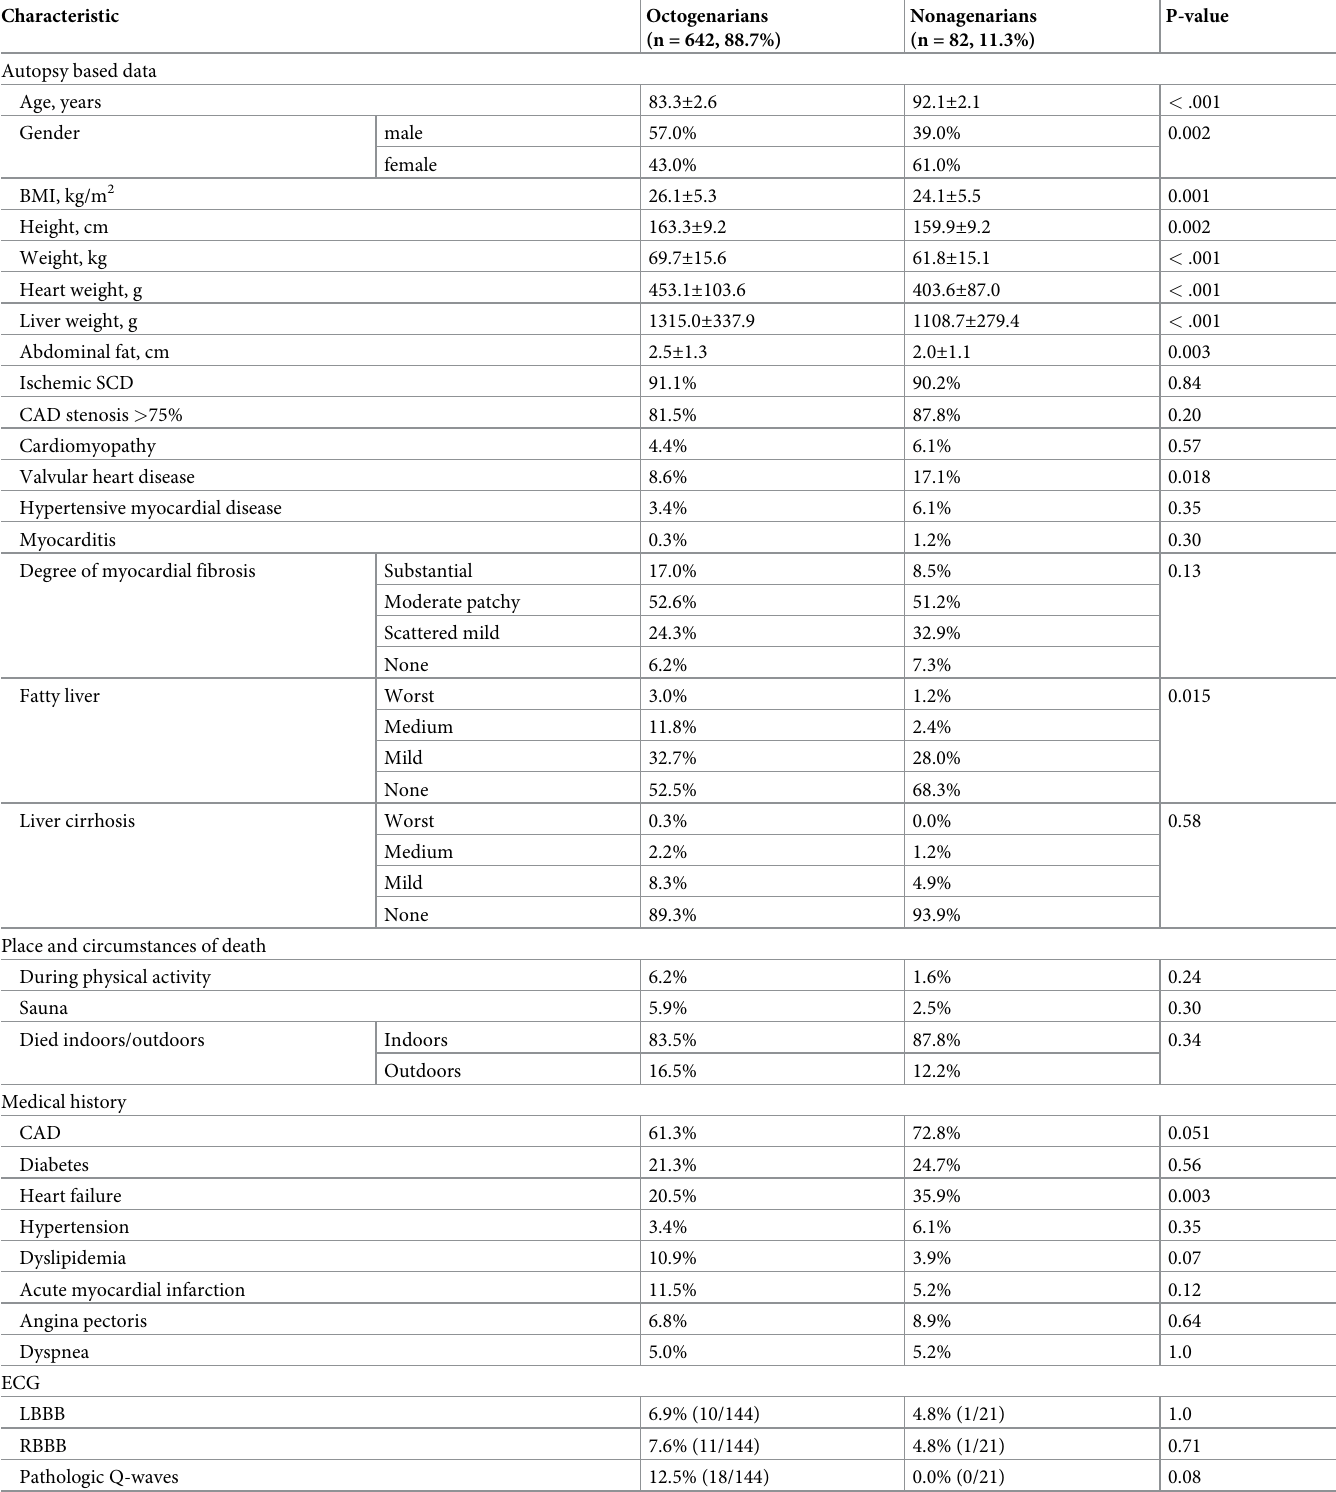
Table 2. Characteristics of octogenarian and nonagenarian sudden cardiac death